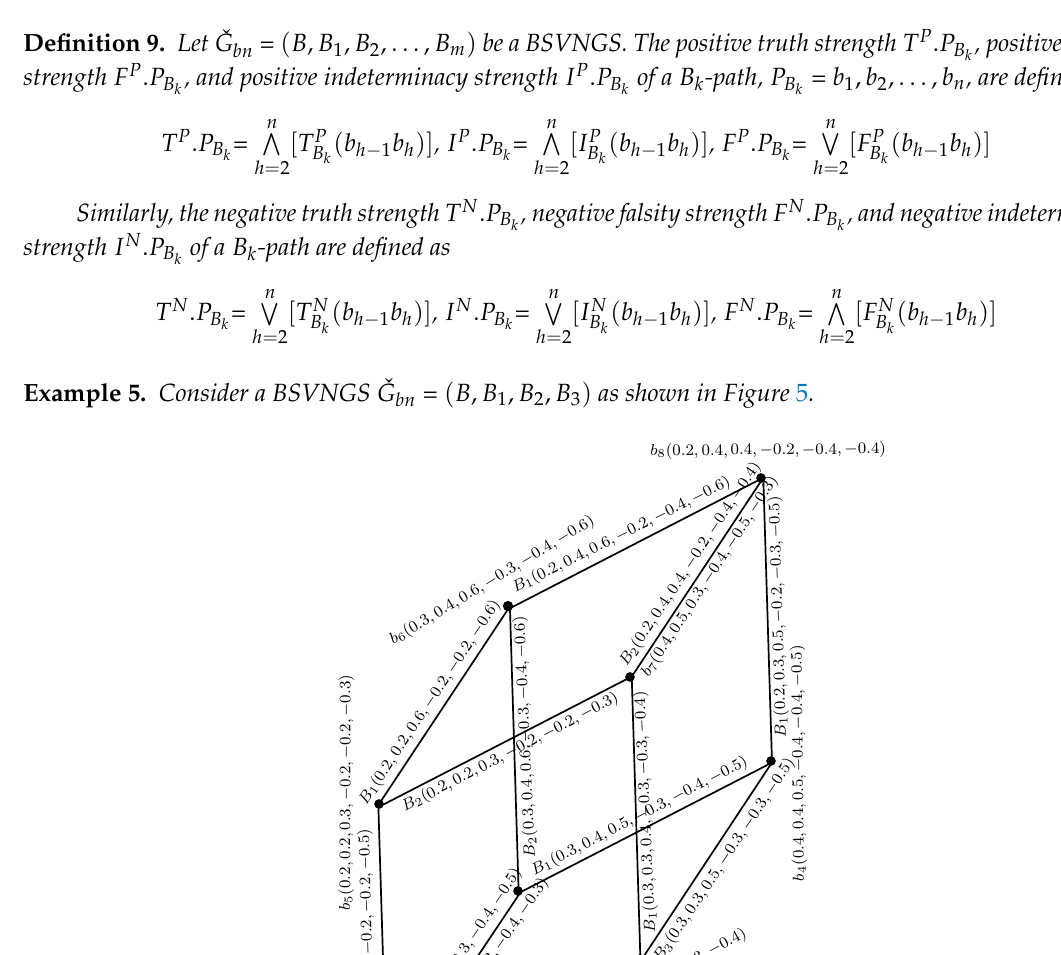
Figure 4. A BSVN B 2 -path. Figure 2.4: A bipolar single-valued neutrosophic B 2 -path